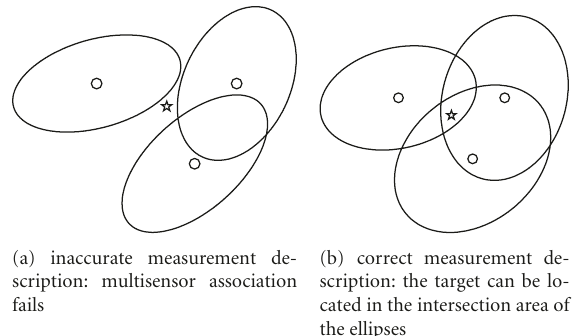
Figure 3: Visualisation of multi sensor fusion. The measurement information of three S/R pairs is visualized by ellipses. The true target location is shown as a